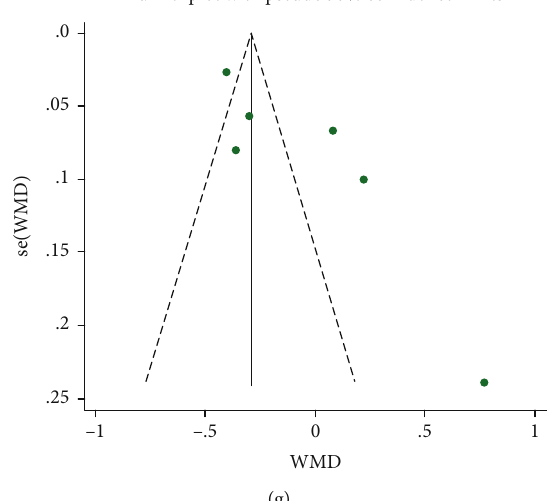
Figure 9: Funnel plots of intervention e ff ect indexes ((a) FPG; (b) 2hPG; (c) HbA1c; (d) TC; (e) TG; (f) LDL-C; (g)